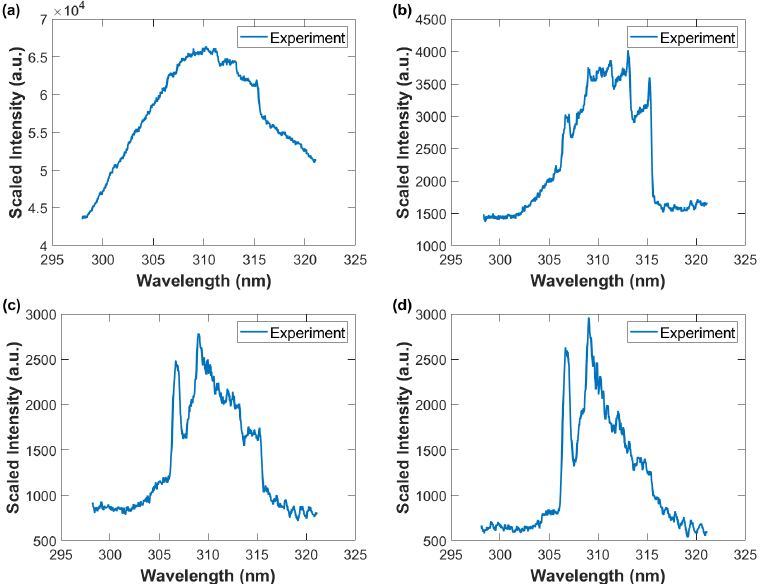
Figure 11. Wavelength-calibrated and sensitivity-corrected spectra average vs. wavelength. The OH A-X 0-0 band edge near 306nm is the initial indicator of presence of the hydroxyl radical. Gate width: 10 µ s, time delay ( a ) 10 µ s—OH and N 2 second positive barely developed ( b ) 20 µ s—primarily N 2 second positive spectra, ( c ) 30 µ s, and ( d ) 40 µ s—primarily OH uv A-X